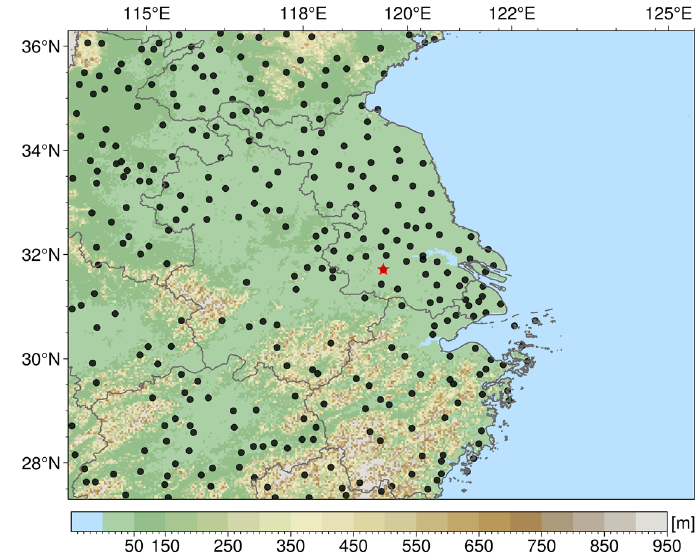
Figure 1. The 3 km horizontal resolution area of PRUFS and the distribution of the 311 automatic weather stations (black dots). The background color shows the height of the terrain, and the red star is the station “Jintan”, to be discussed in the later section.